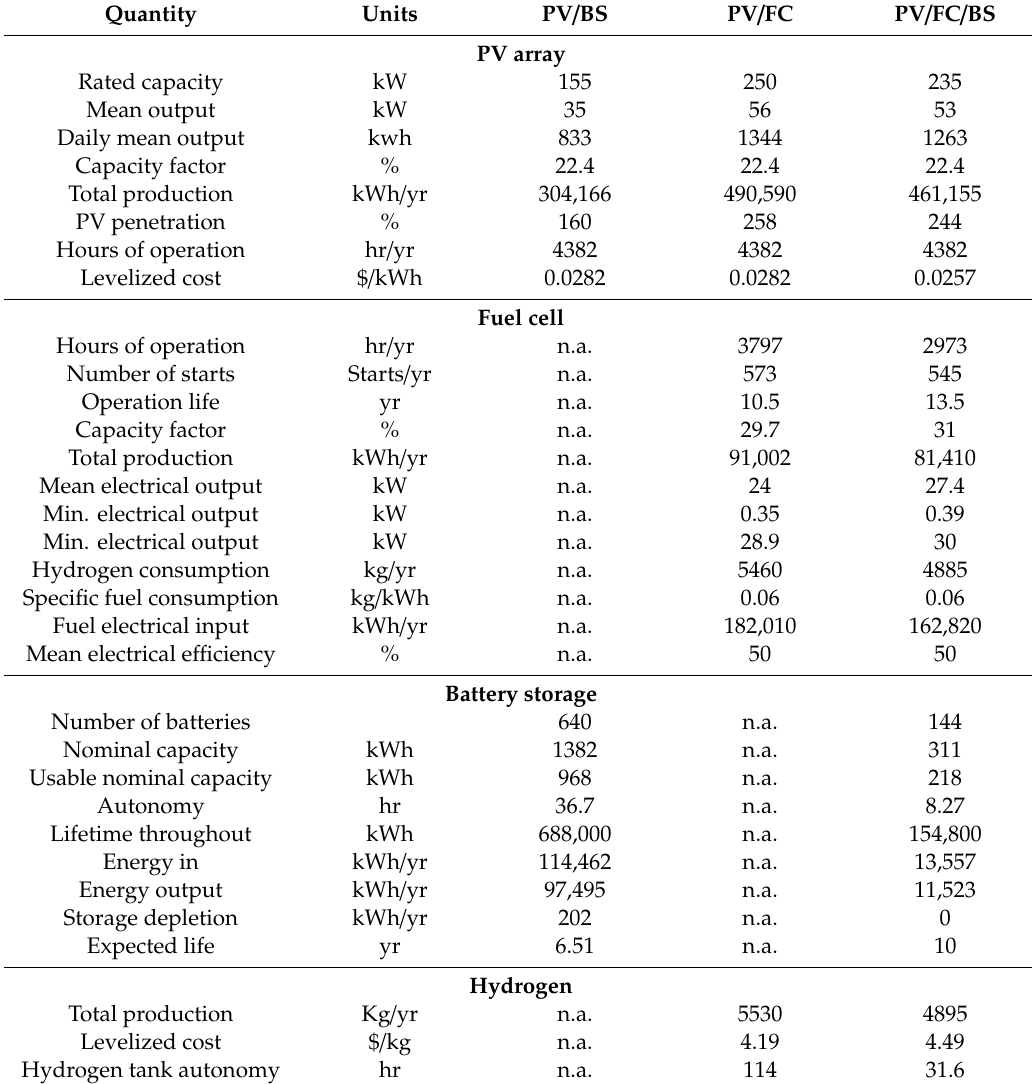
Table 6. The detailed performance of di ff erent components of the